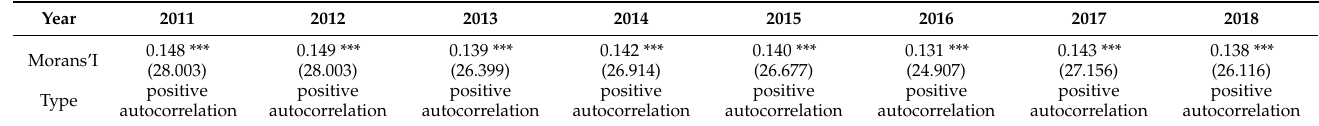
Table 8. Spatial correlation of the coupling and coordination between digital economy development and carbon emissions